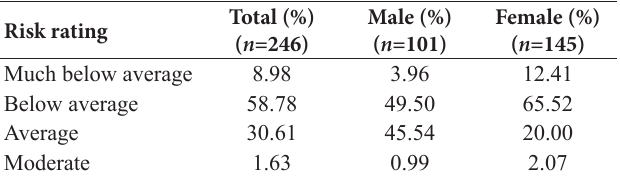
Table 2. Distribution of coronary risk.